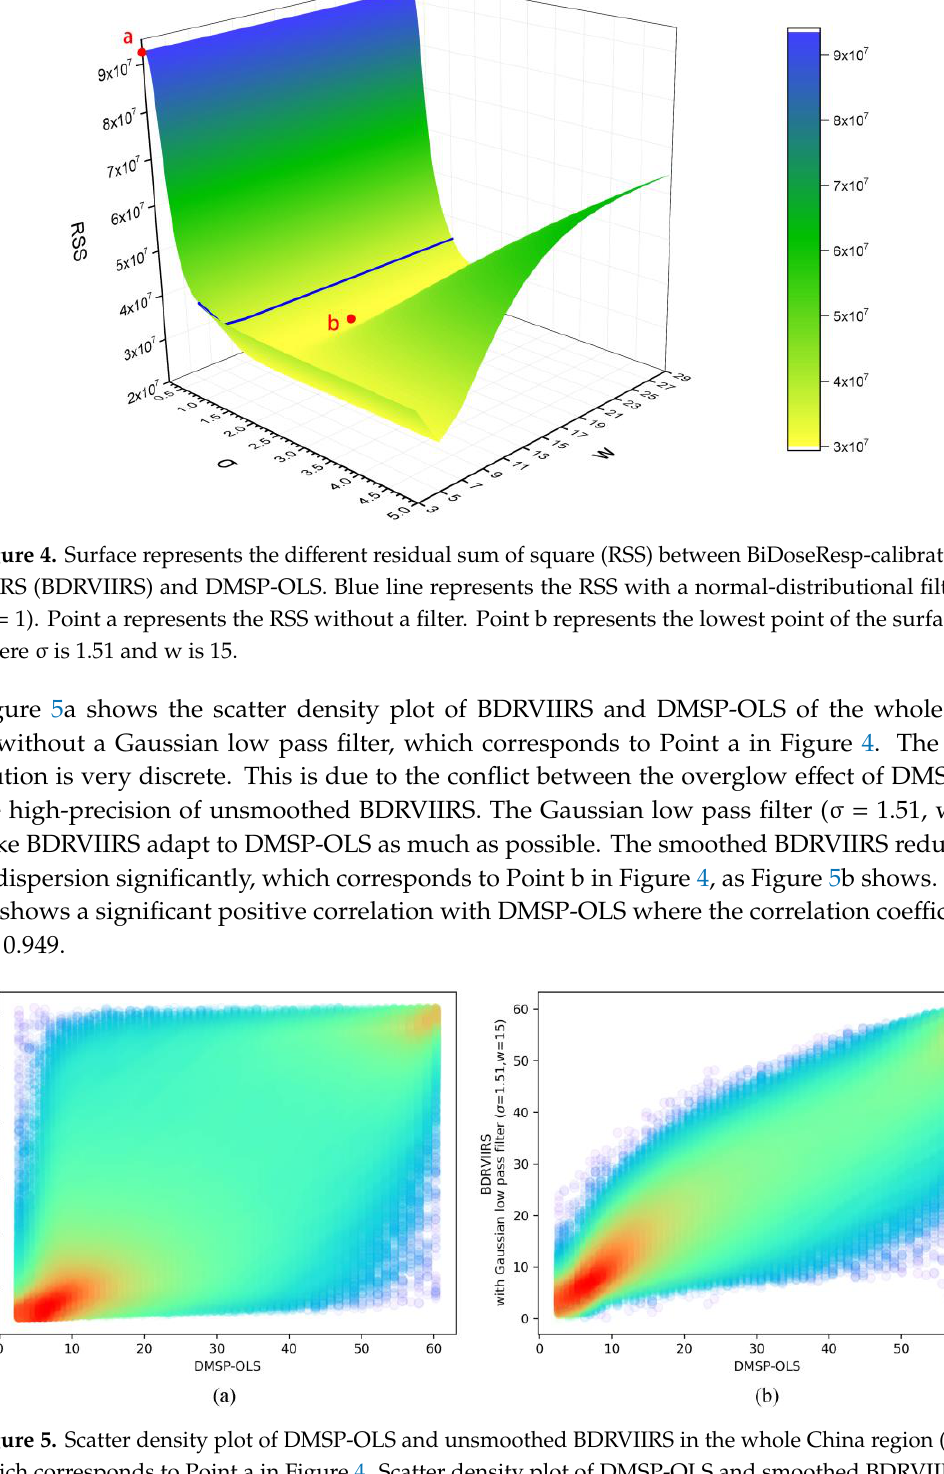
Figure 5. Scatter density plot of DMSP-OLS and unsmoothed BDRVIIRS in the whole China region ( a ), which corresponds to Point a in Figure 4. Scatter density plot of DMSP-OLS and smoothed BDRVIIRS undergoing a Gaussian low pass filter ( σ = 1.51, w = 15) ( b ), which corresponds to Point b in Figure